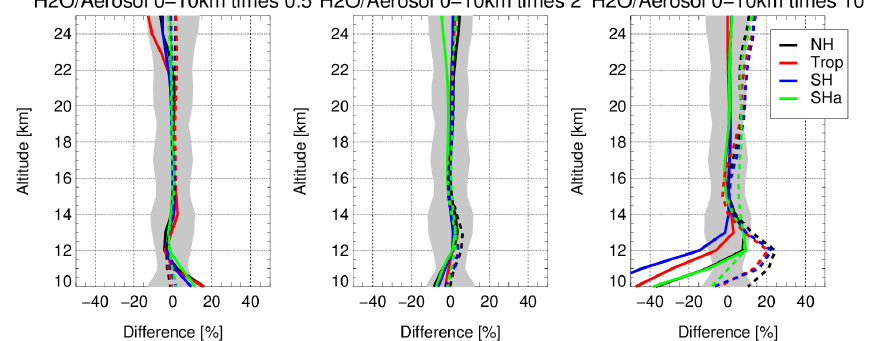
Figure 6. End-to-end test for different perturbations of the aerosol (dashed lines) and water vapour (solid lines) profile below the retrieval heights (0–10km). The four colours show different observation geometries; the three panels show different perturbations. The grey shading shows the maximum of retrieval errors. The smoothing with the AVK is done for all cases.